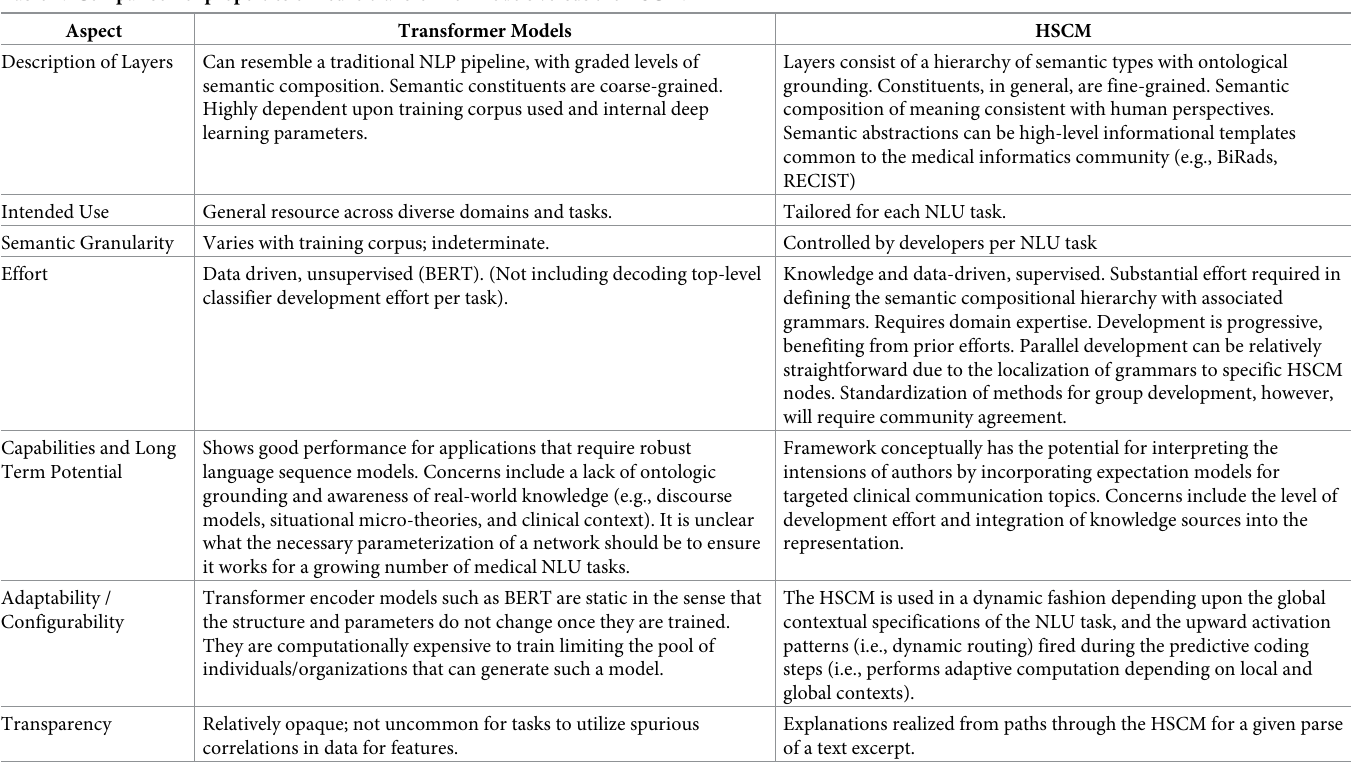
Table 2. Comparison of properties of neuro transformer models versus the